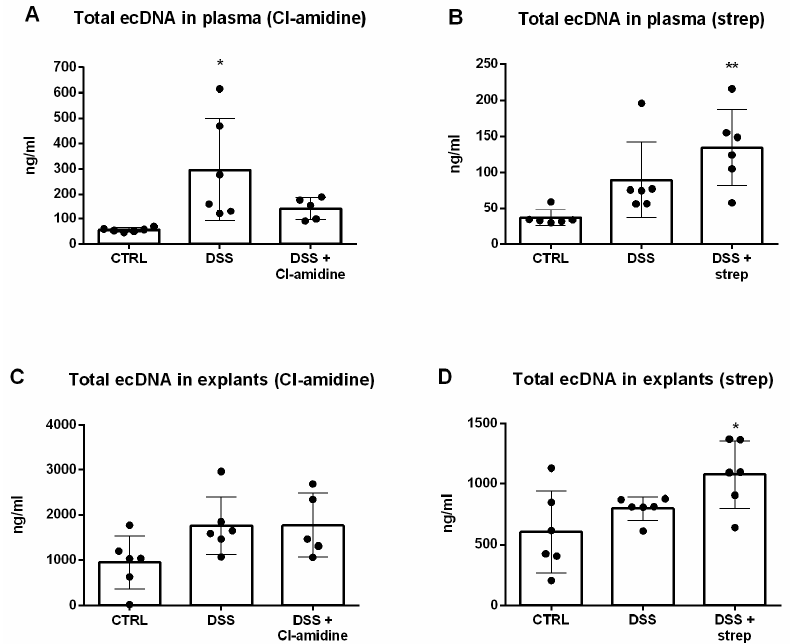
Figure 9. Cl-amidine treatment led to decrease of the concentration of total ecDNA in plasma ( A ), however this effect was not observed upon strep treatment ( B ). The concentration of total ecDNA in explants was not lower compared to positive control in either Cl-amidine ( C ) or strep ( D ) treatment. * = p < 0.05; ** = 0.05 > p > 0.01